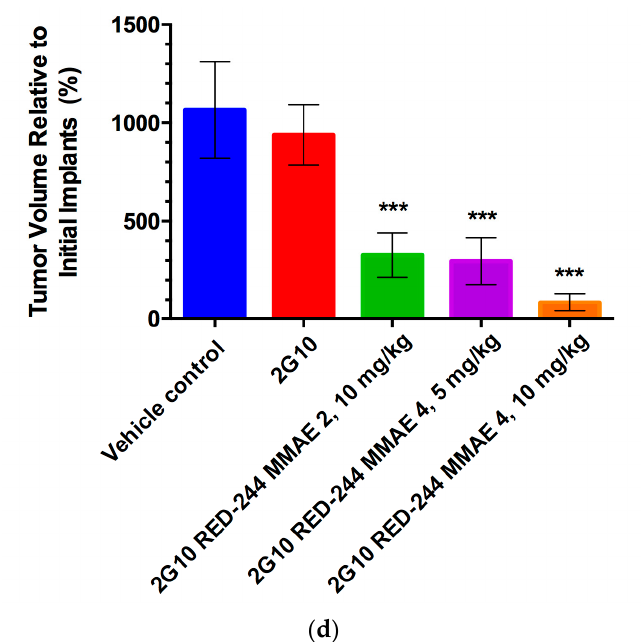
Figure 5. Effect of anti-uPAR 2G10 ADCs on tumor growth ( a ) Schematic of the in vivo experiment to evaluate seven SMARTag based anti-uPAR 2G10 ADCs. Asterisks indicates time of injection. ( b ) Comparison of tumor growth with various 2G10 ADCs coupled with maytansine and MMAE. Linker RED106 is non-cleavable, other are cleavable. ( n = 4, Error bars indicate SEM) ( c ) Summary of percent tumor volume (Error bars indicate standard deviation) relative to the initial volume (100%, 100 mm 3 ) at endpoint for various treatments (all at 10 mg/kg dose). ( d ) 2G10-RED-244-MMAE dose–response ( n = 10, Error bars indicate standard deviation). For ( c ) and ( d ) Asterisks indicate significance level comparted to vehicle-treated. Multiplicity-adjusted P values from the Holm-Šidák method. * p < 0.05; ** p < 0.01; *** p < 0.001; **** p < 0.0001.